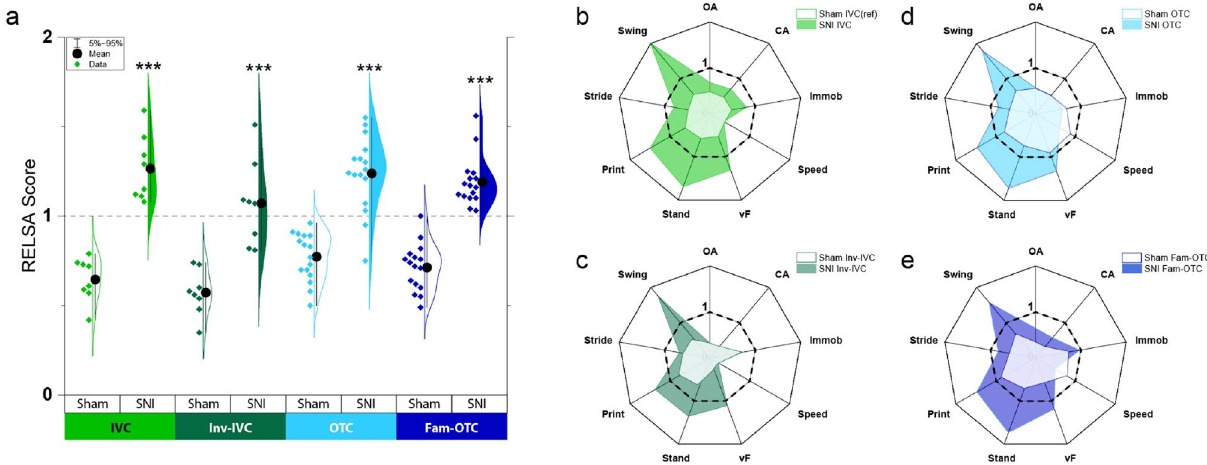
Figure 4. The Relative Severity Assessment (RELSA) score reveals group-dependent severity differences. ( a ) The violin plot shows the individual RELSA scores in the Sham and spared nerve injury (SNI) groups. The average RELSA values of the Sham groups are < 1, whereas the SNI groups show higher severity with RELSA averages of > 1. The differences between Sham and SNI groups were significantly different, with at least p < 0.05 after Tukey post hoc testing. However, no between sham or between SNI differences were found. The spider plots show the averaged variable contributions (RELSA weights) to the RELSA score. ( b ) In the SNI individually ventilated cages (IVC) group, the Swing variable has notably the most considerable contribution to the RELSA (RW = 2.02), followed by Print (RW = 1.5), Stand (RW = 1.69), and vF (RW = 1.3). The Speed variable shows the lowest contribution (RW = 0.35). Note the consistent pattern in variable contributions in groups ( c ) to ( e ). The central areas with lighter colors show the variable contributions in the Sham groups, which are considerably smaller than the SNI groups (e.g., AUC SNI-IVC = 1.09 vs. AUC ref = 0.51). (Inv-IVC: inverted day night cycle of IVC; OTC: open top cages without and Fam-OTC with experimenter